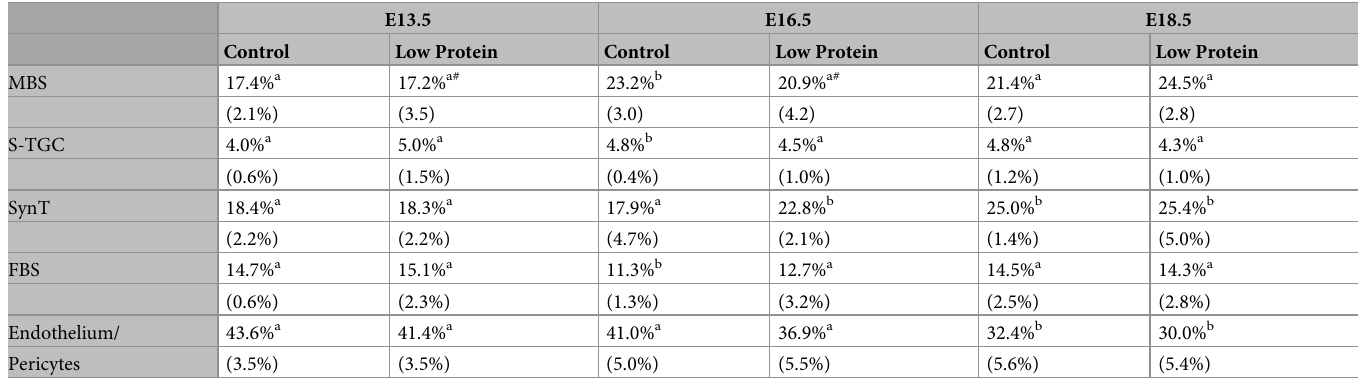
Table 2. Labyrinth composition expressed as a percent area. (mean; SEM in